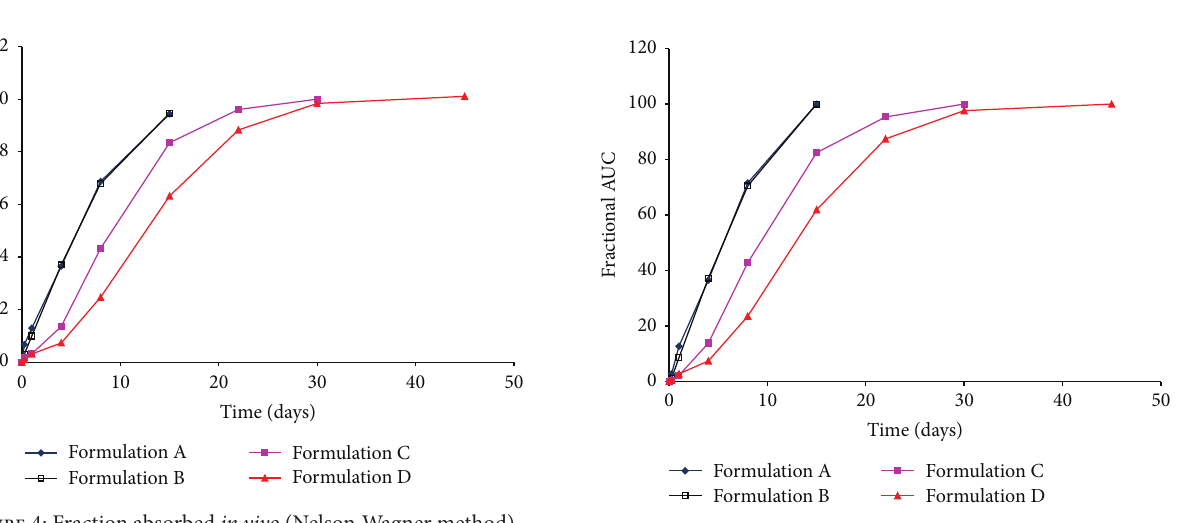
Figure 5: Fractional AUC profile of Olanzapine PLGA micro-